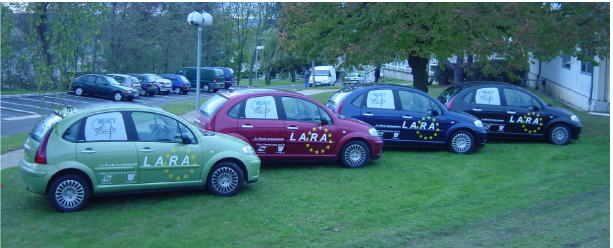
Figure 5. Testing vehicles